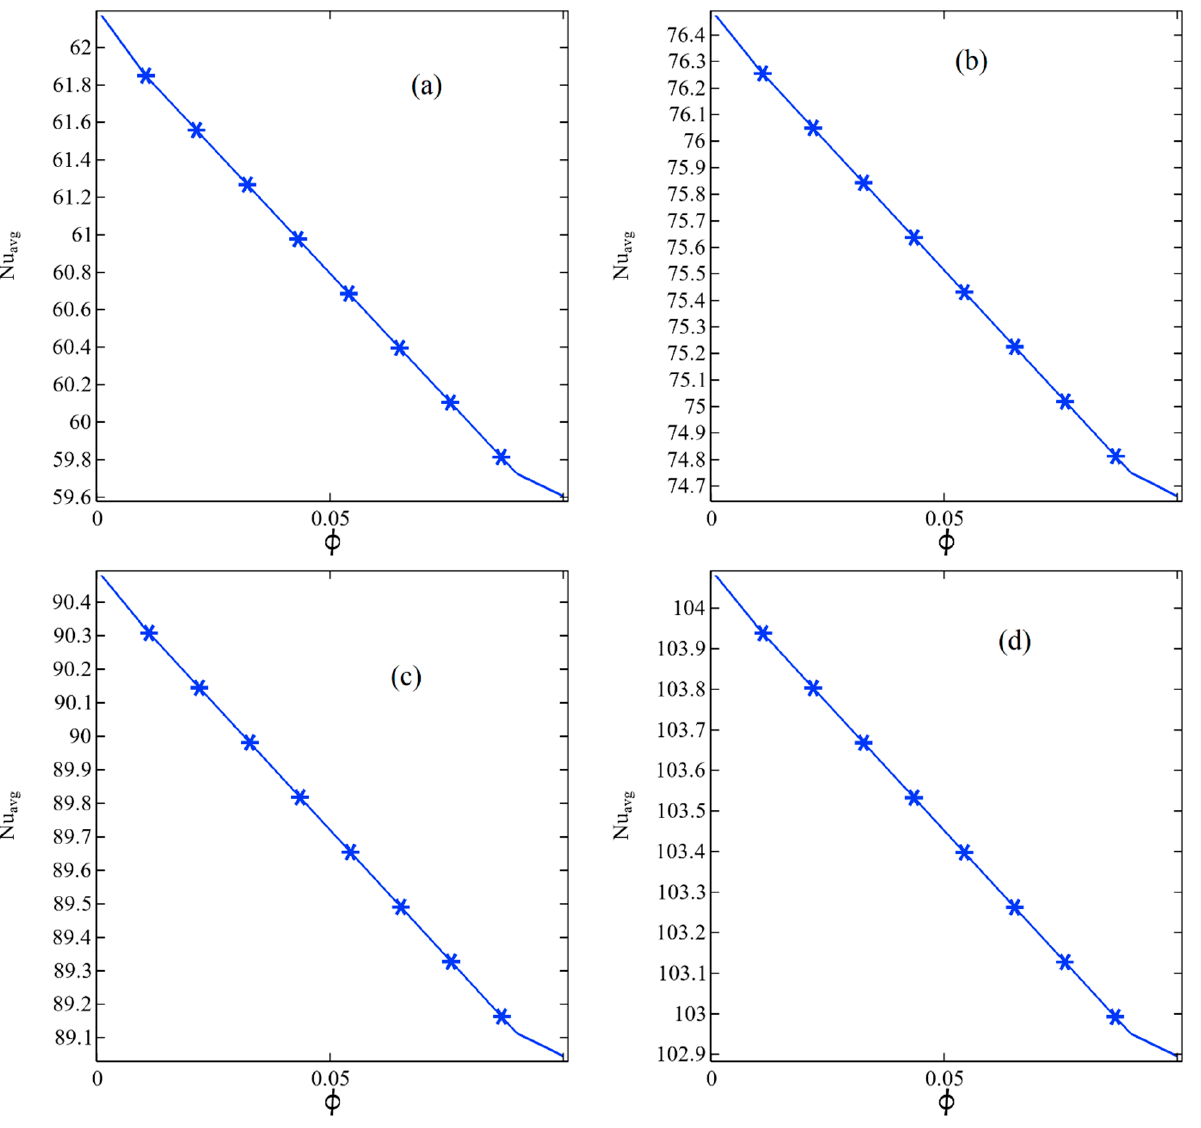
Figure 5. The average Nusselt number against increasing volume fractions with ω = 0.5: ( a ) Re = 30,000, ( b ) Re = 40,000, ( c ) Re = 50,000, and ( d ) Re = 60,000.